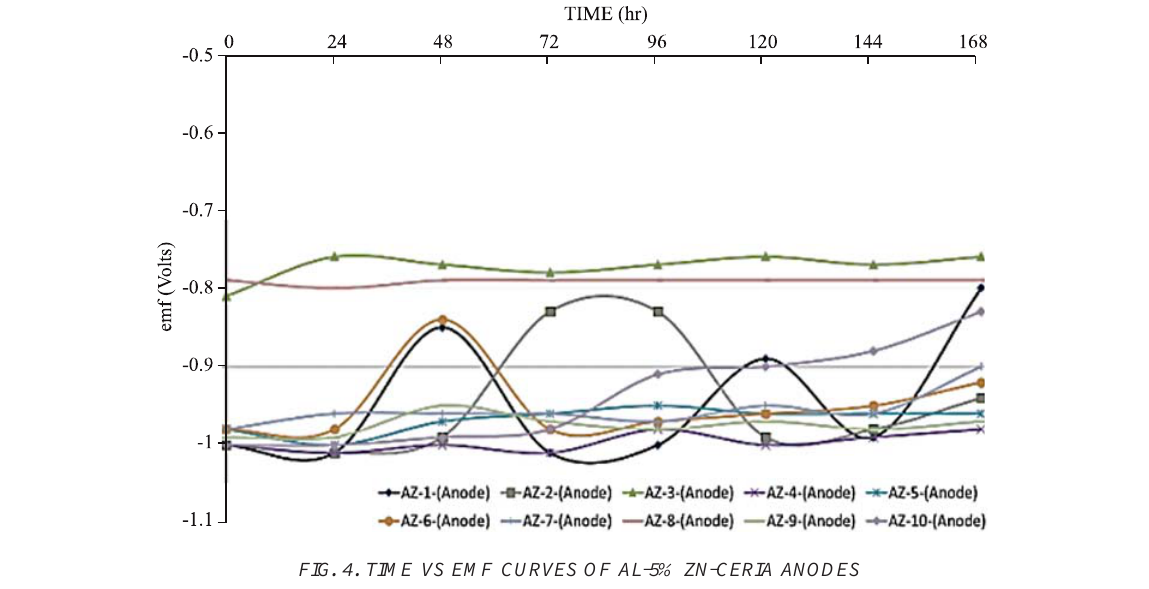
FIG. 4. TIME VS EMF CURVES OF AL-5% ZN-CERIA